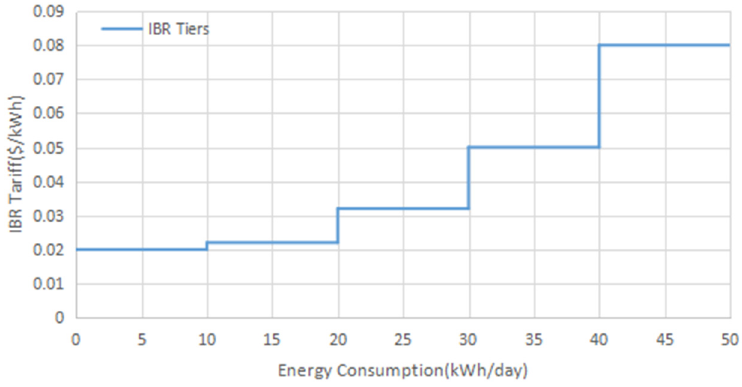
Solid line: Original price Dashed Line: Ladder price P 1 i P 2 i Figure 1. TOU and ladder price electricity price scheme.